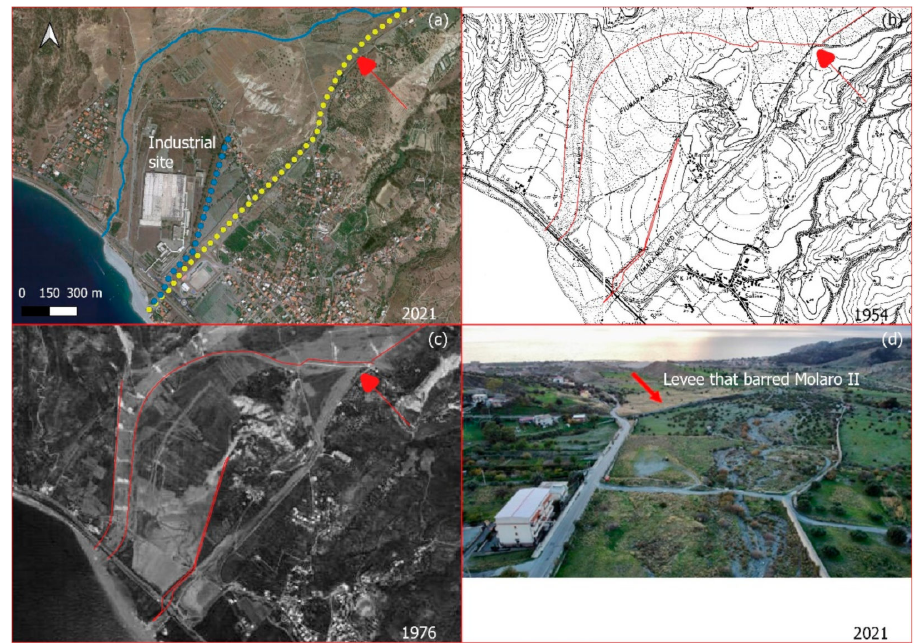
Figure 3. The Molaro River. ( a ) An image from Google Earth from September 2021. ( b ) The CASMEZ cartography of 1954. ( c ) The aerial photogrammetry of 1976. ( d ) The view from a drone of the levee that barred Molaro II (view from the mountain to the valley). The yellow lines are the 1954 riverbanks, the red lines are the 2021 riverbanks, the blue line is the 2021 Molaro I River, the dashed blue line is the 2021 Molaro II River and the dashed yellow line is the 1954 Molaro I River. The arrows identify the point where the levee that barred the Molaro II River was built.